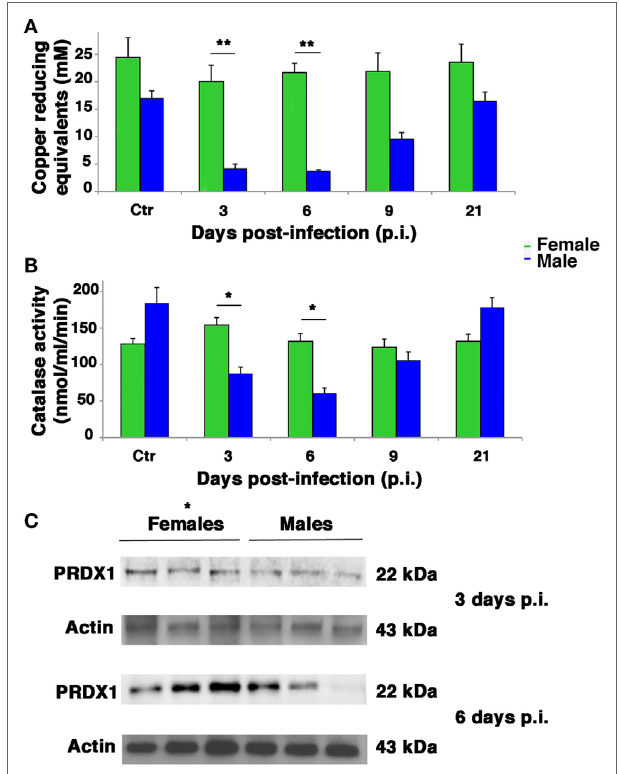
FigUre 6 | Antioxidant defenses are higher in infected female mice. (a) Serum from mock-infected (Ctr) and PR8-infected mice was collected on p.i. days 3, 6, 9, and 21 and assayed with the potential antioxidant test, which measures the total antioxidant power in terms of the sample’s ability to reduce copper. (B) Lung homogenates from Ctr and PR8-infected mice were assayed for CAT activity at the same time points than in panel (a) . Each value reported represents the mean ± SD of results from two separate experiments, each performed in duplicate ( n = 4), * p -value < 0.05 and ** p -value < 0.01. (c) Peroxiredoxin (PRDX)1 protein expression was analyzed by western blotting in the lungs of infected female and male mice. Actin was used as loading control. Blot shows three animals for each sex (* p -value ≤ 0.05) and is representative of three independent experiments